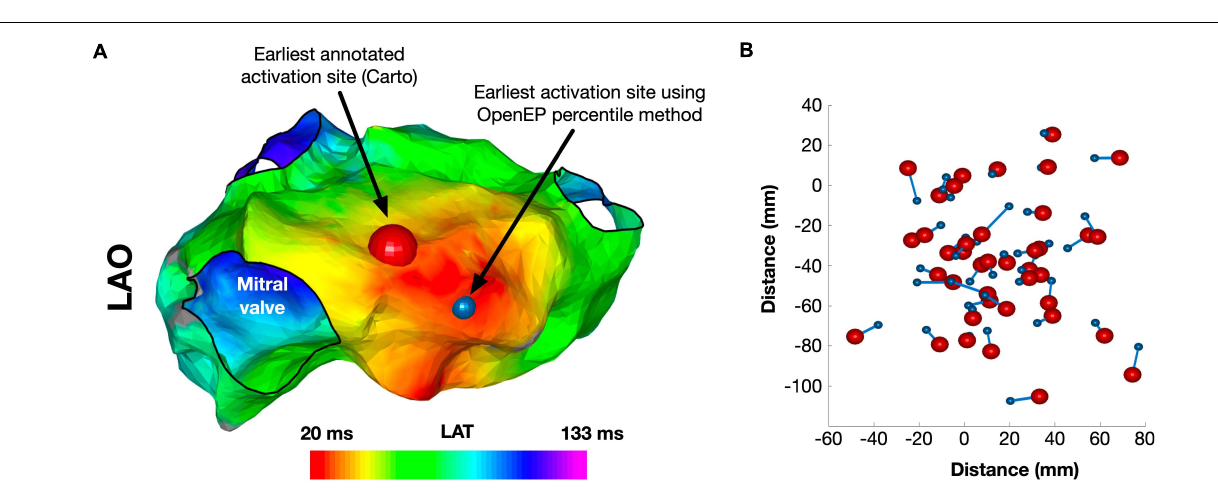
FIGURE 7 | Identification of the site of earliest activation. (A) Example activation map showing the site of earliest activation, defined as the earliest local activation time recorded by Carto shown in red, and the site of earliest activation using the OpenEP percentile method shown in blue. (B) Relationship between Carto earliest activation sites and OpenEP earliest activation sites for all 40 cases. The Carto-defined earliest activation sites are shown with red spheres and the OpenEP-defined earliest activation sites are shown with blue spheres. The connecting lines indicate the pairing of data points on a case-by-case basis. LAO, left anterior oblique; LAT, local activation